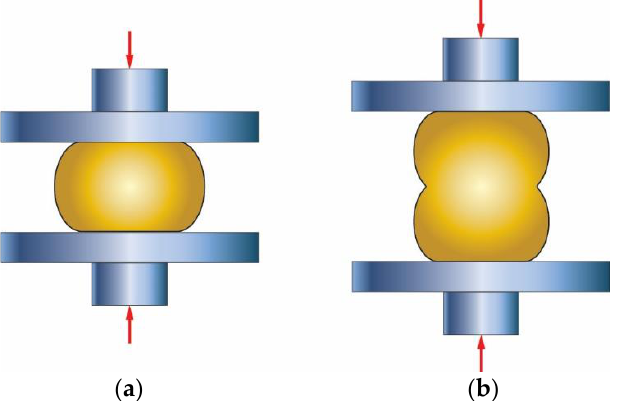
Figure 2. Deformation modes in compression; ( a ) single barrel, (b ) double barrel, adopted from [7].